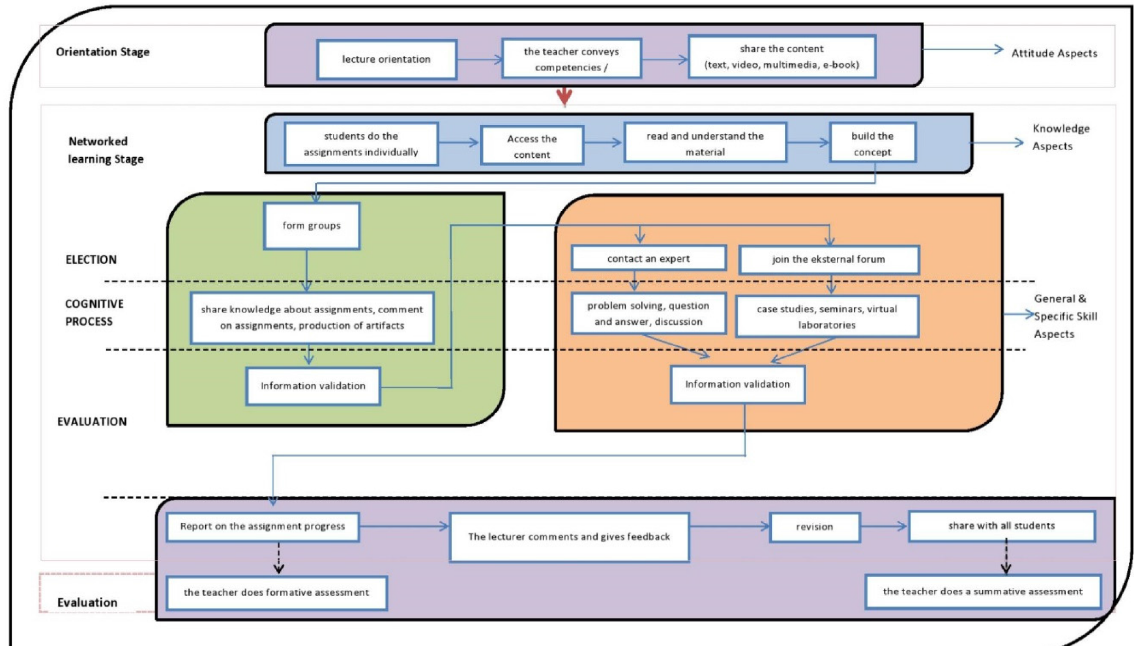
Figure 5. Final prototype of the online learning network design